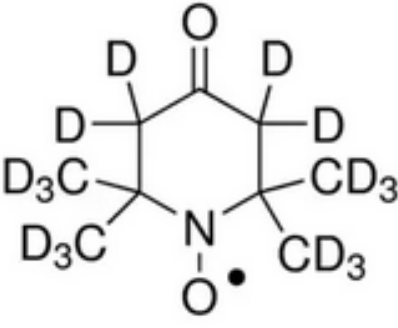
Figure 7. Molecular structure formula of 15 N-D-oxo-TEMPO. The coaxial resonator is composed of a quartz bottle filled with a free radical solution and metal strips attached to the inside and outside of the container. Either the inner or outer conductor has gaps to prevent an eddy current. The length and the volume of the container are 112 mm and 175 mL, respectively. A simulation model for the coaxial reso- ( c ) Figure 8. Coaxial cavity HFSS model ( a ), cross sectional magnetic field distribution ( b ) and S 11 of resonant cavity ( c ).